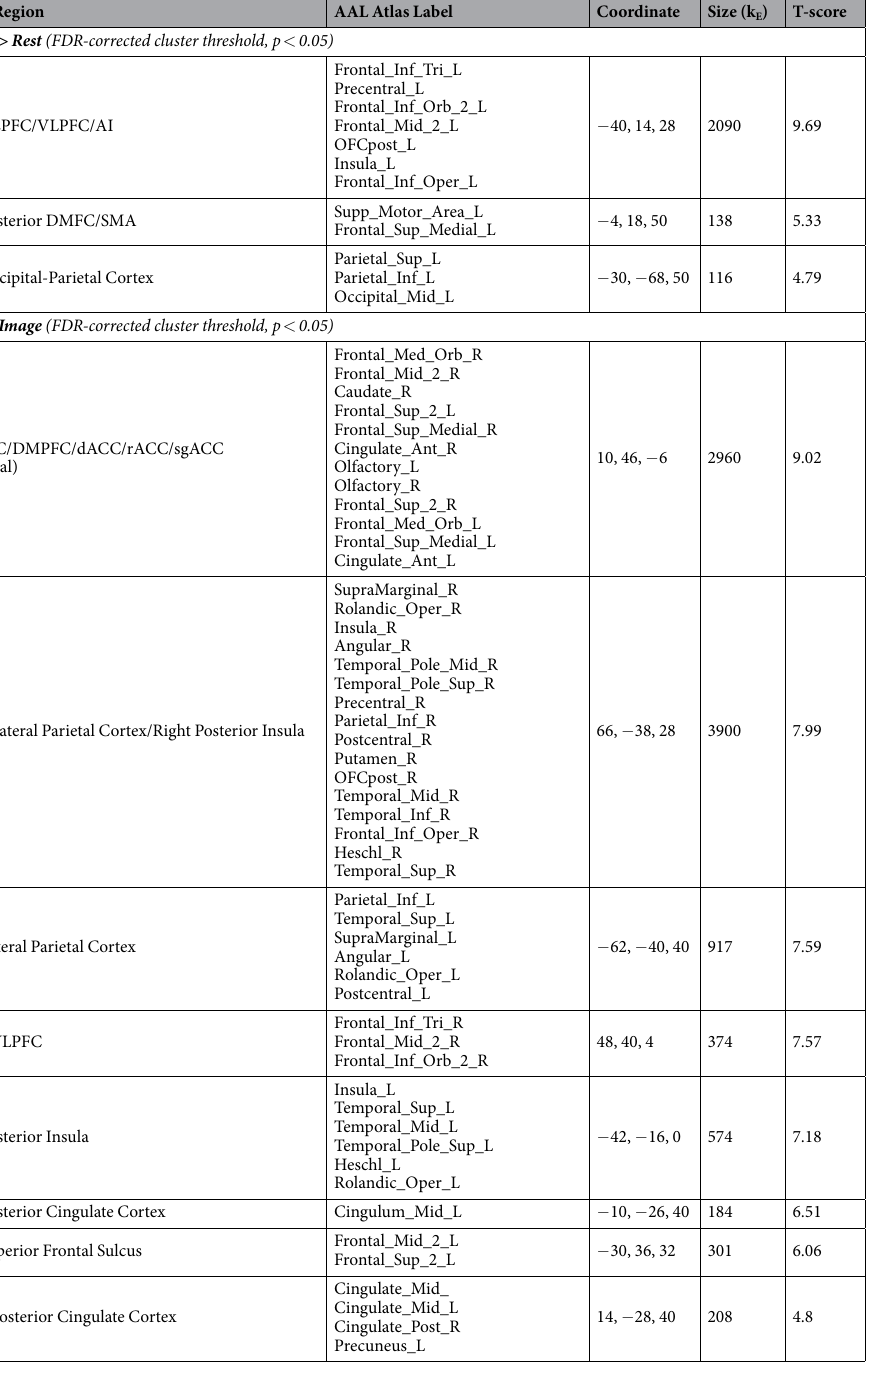
Table 3. fMRI Results: Image vs.